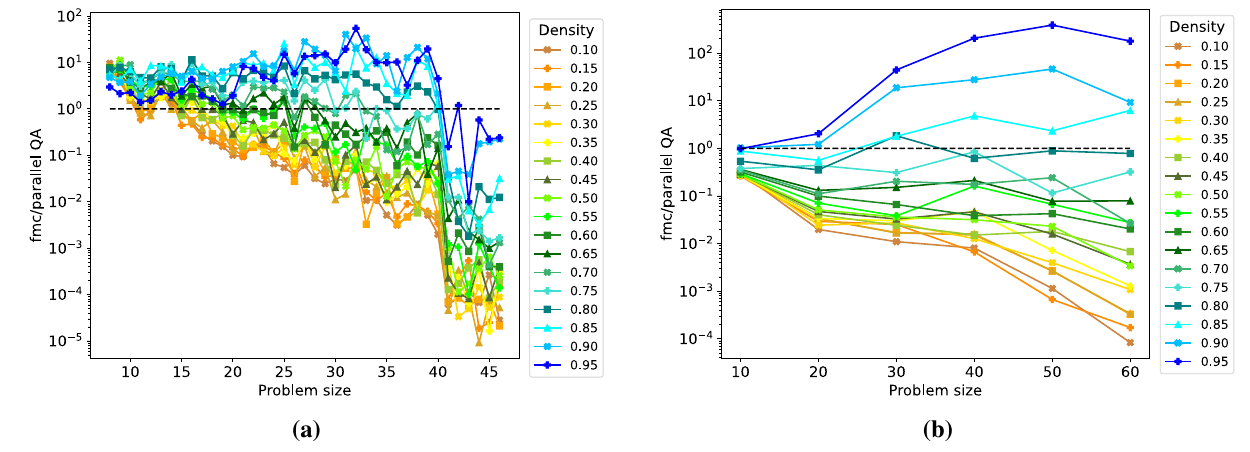
Figure 6. Speedup of using parallel quantum annealing compared with the classical FMC solver as a function of the problem size for DW 2000Q ( a ) and DW Advantage ( b ). Log scale on the y-axis. Graph densities range from 0.10 to 0.95 (color coding shown in the legend).